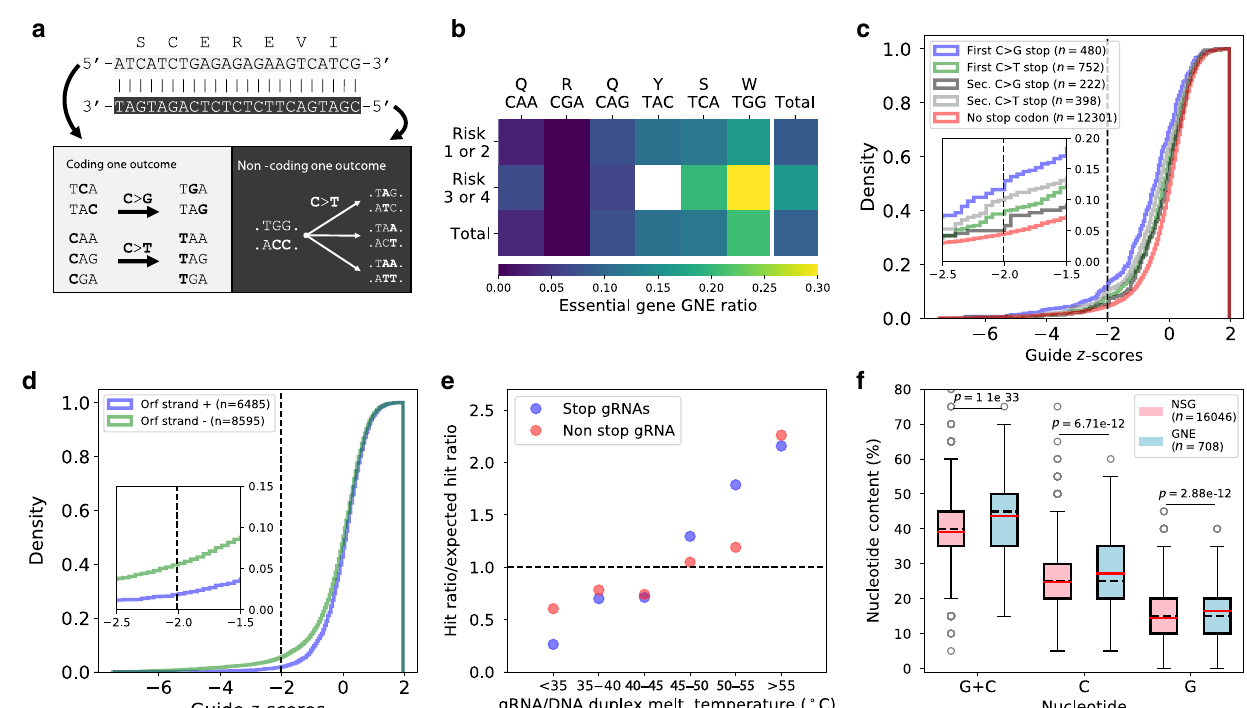
Fig. 6 gRNA and target properties affect mutagenesis ef fi ciency. a Since Target-AID can generate both C to G and C to T mutations, many codons can be targeted to create premature stop codons. The TGG (W) codon is the only one targeted on the non-coding strand as ACC. b GNE ratio for SGGs targeting different codons in essential genes, split by co-editing risk categories, where 1 and 2 represent low or very low co-editing risk while 3 or 4 represent moderate to high co-editing risk. c Cumulative z-score density of SGGs grouped by the mutational outcome generating the stop codon. A higher rate of GNE is observed for gRNAs for which a C-to-G mutation at the highest editing activity position generates a stop codon mutation. The signi fi cance threshold is shown as a black dotted line. d Cumulative z-score density of gRNAs that do not generate stop codons targeting either the coding or non-coding strand. e SGG and non-SGG GNE enrichment compared to the expected GNE ratio for different melting temperature ranges. f GC, C, and G content of NSGs and GNEs. Distribution medians are shown as black dotted lines and means are shown as red lines. P -values were calculated using Welch ’ s t-tests. Boxplots represent the upper and lower quartiles of the data, and whiskers extend to 1.5 times the interquartile range (Q3 – Q1) at most. Outliers are shown in